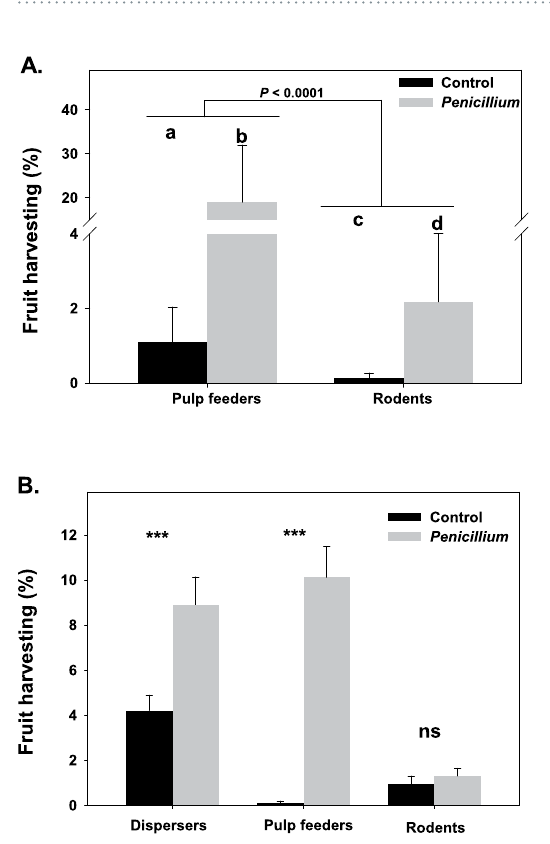
Table 1. Results of main effect tests using generalized linear mixed models on the effects of Penicillium digitatum infestation (P) and consumer guild (G), as well as their second-order interaction, on percentages of fruit harvesting in Mediterranean and tropical sweet orange ( Citrus sinensis ) groves.